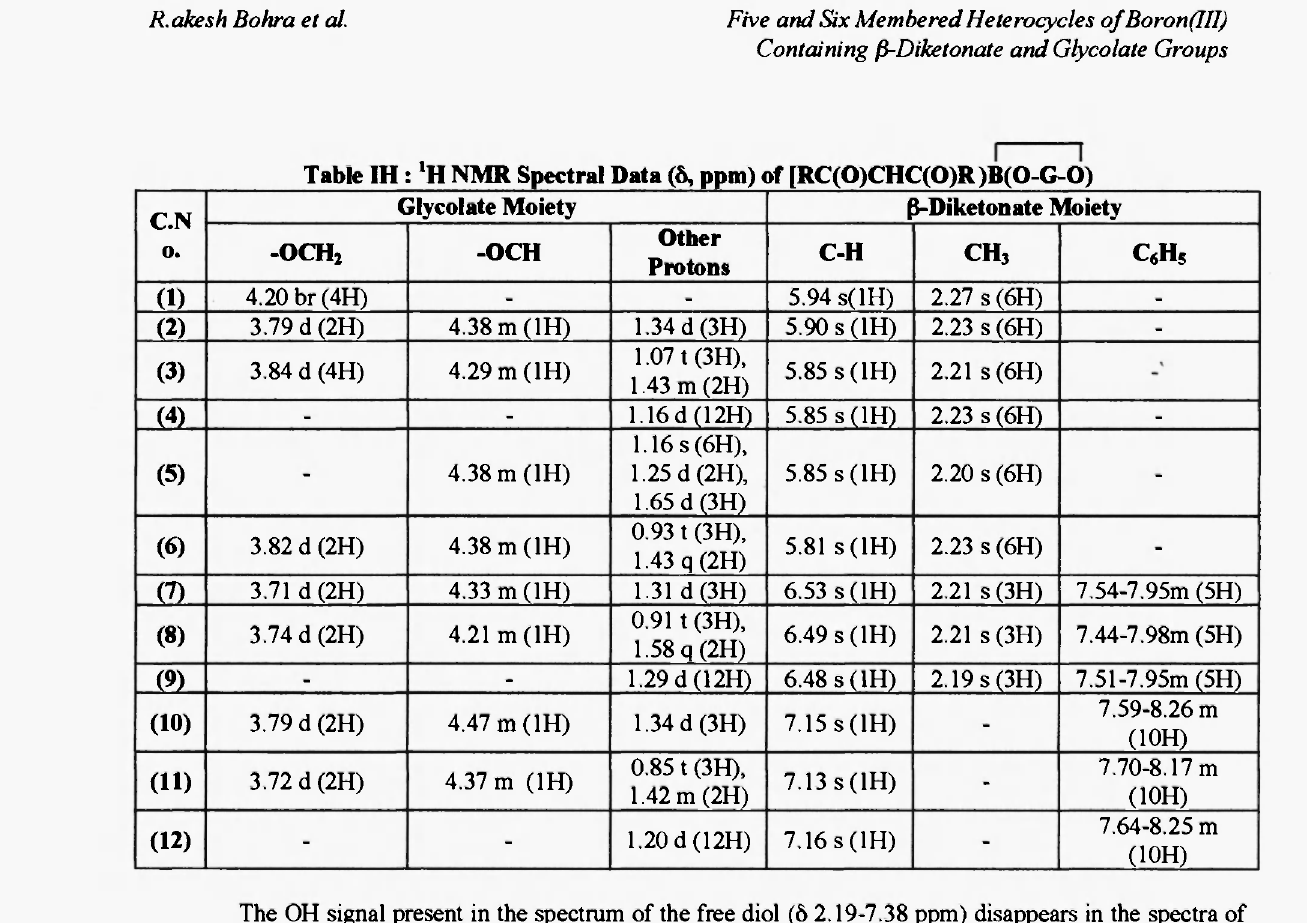
Table IH : 'H NMR Spectral Data (δ, ppm) of